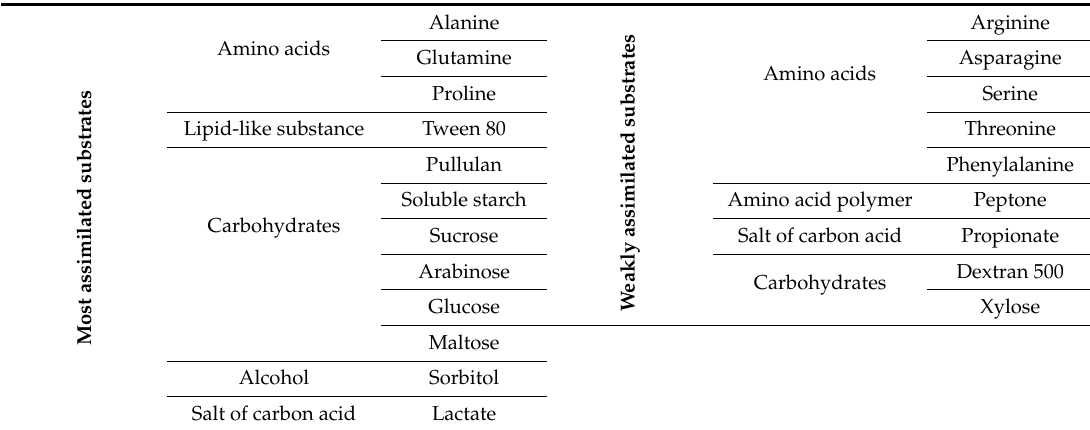
Table 3. Substrate assimilation obtained by multisubstrate